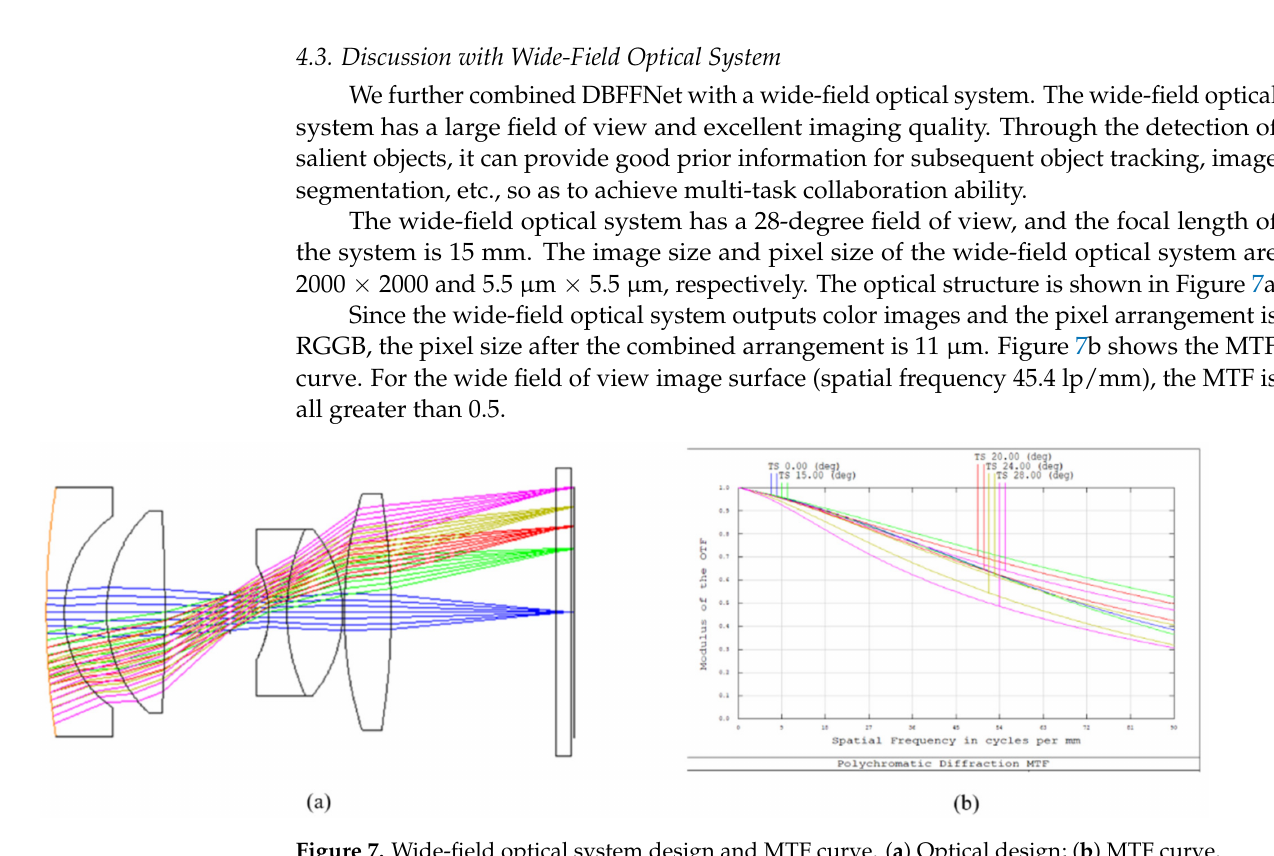
Figure 8. Wide-field optical system spot diagram together with field curvature and distortion. ( a ) Spot diagram; ( b ) field curvature and distortion.